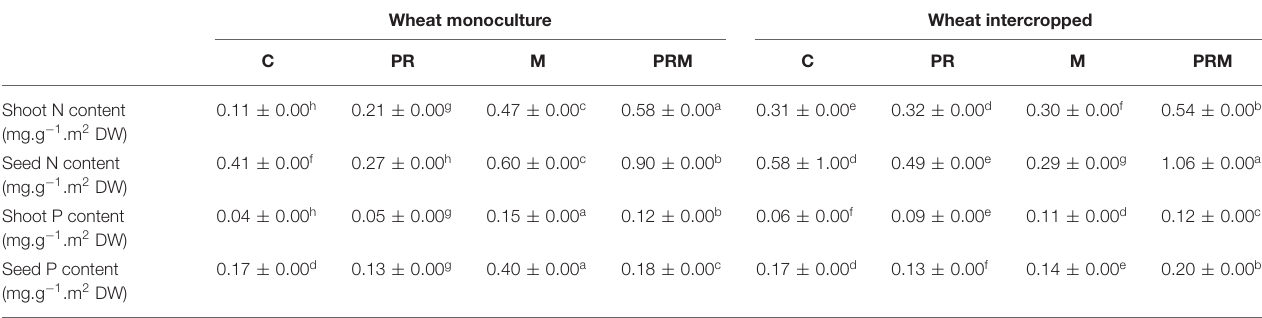
TABLE 3 | Effect of intercropping and inoculation with rhizobacteria consortium (PR), mycorrhizae (M), and their combination (PRM) on wheat phosphorus and nitrogen concentration after 5 months of culture. Wheat monoculture Wheat intercropped